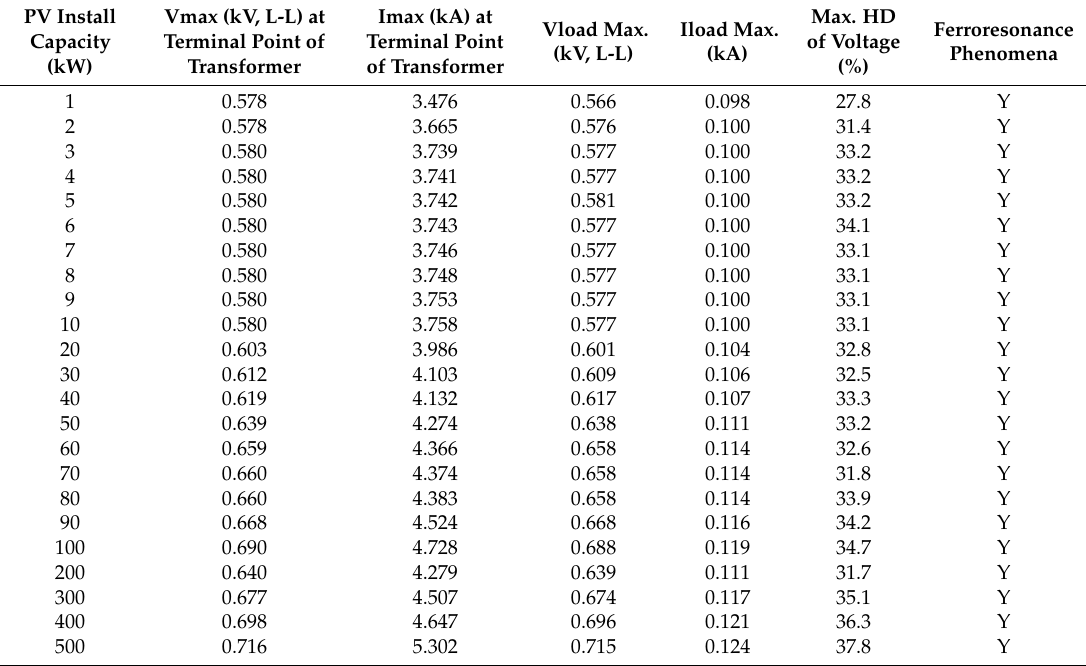
Table 3. The simulation results of the increasing installation capacity of the PV